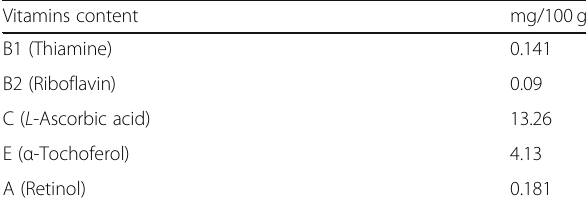
Table 4 Vitamin content (mg/100 g) of dried pomegranate